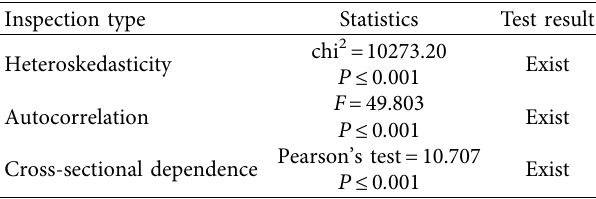
Table 4: Model parameter estimation test in the whole country.